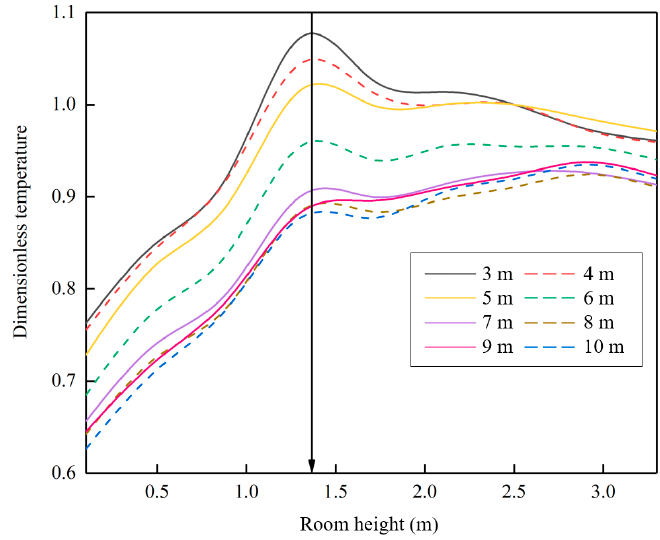
Figure 9. Change of dimensionless temperature at different heights with various room sizes.